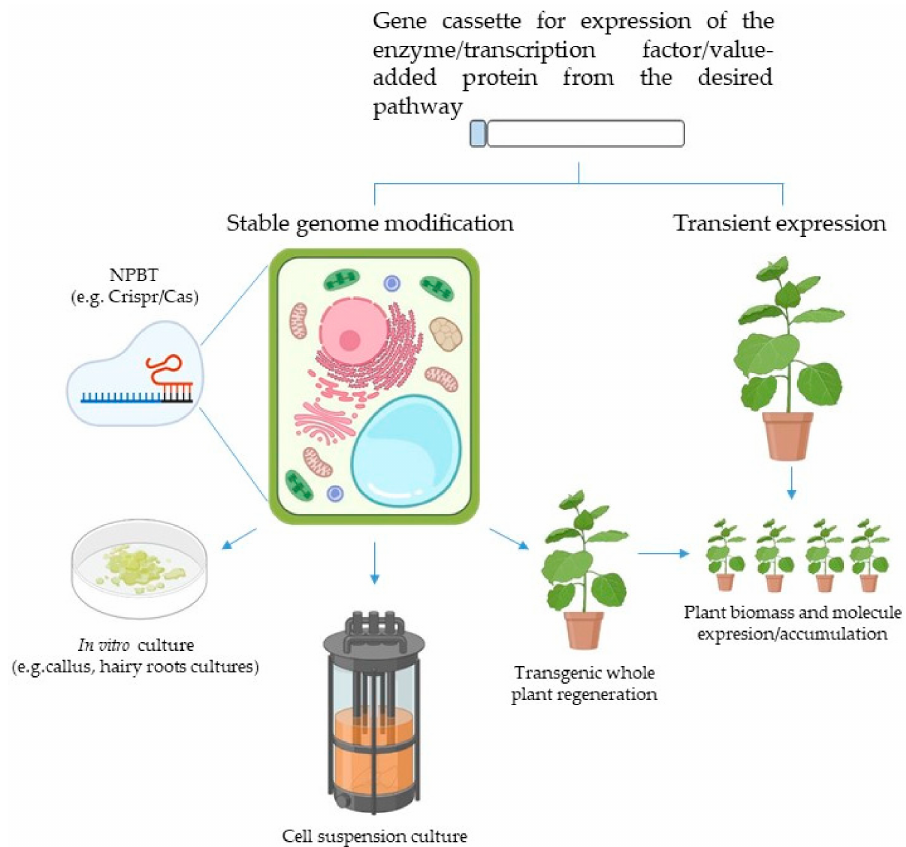
Figure 3. The plant molecular farming approach. Through stable or transient expression of re- combinant proteins, either exogenous proteins and metabolites accumulation or improvement of biosynthesis pathways can be achieved (NPBT: new plant breeding techniques; Crispr-Cas: clustered regularly interspaced short palindromic repeats–Crispr-associated